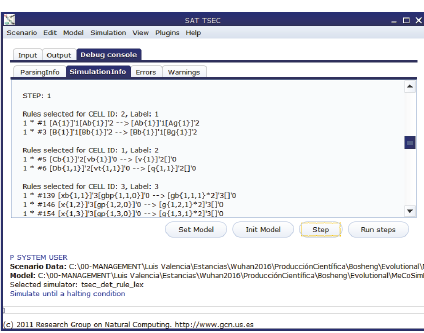
Figure 7: Step by step simulation process.